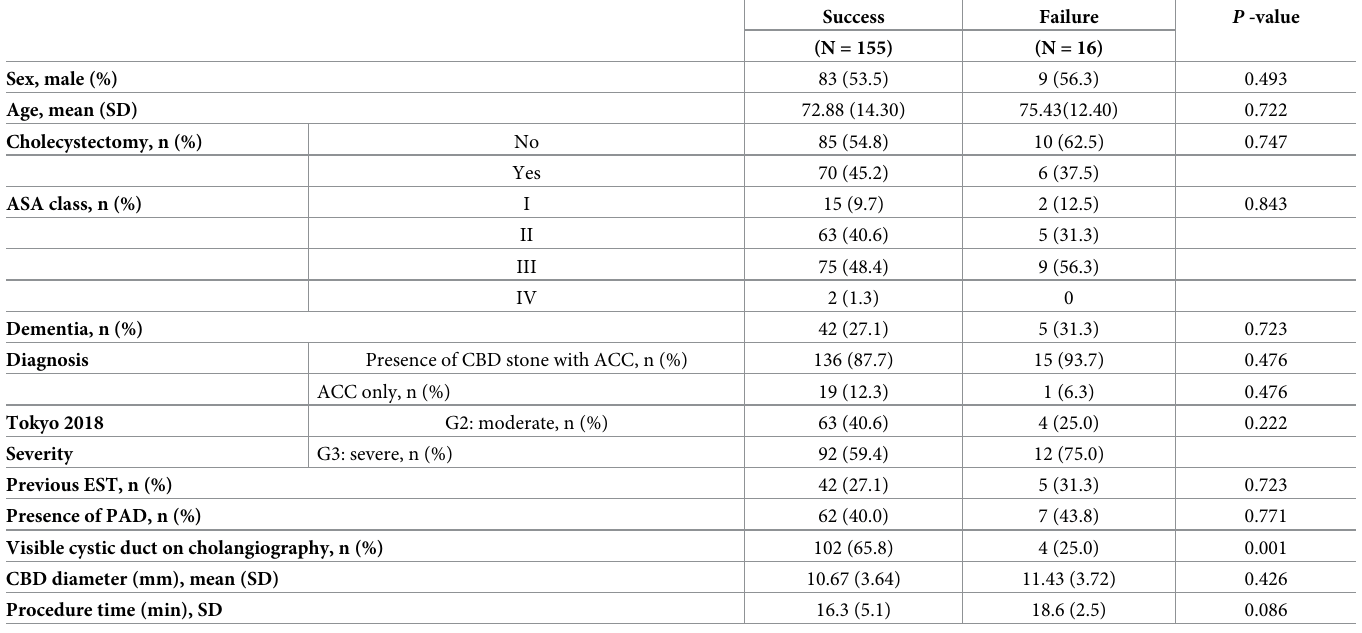
Table 1. Baseline characteristics of the study population (n = 171).